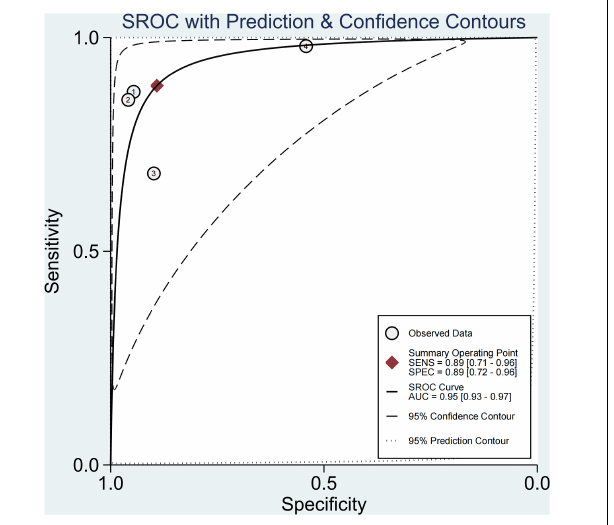
FIGURE 10 | Summary ROC curve of diagnostic performance of elastography for advanced fibrosis.